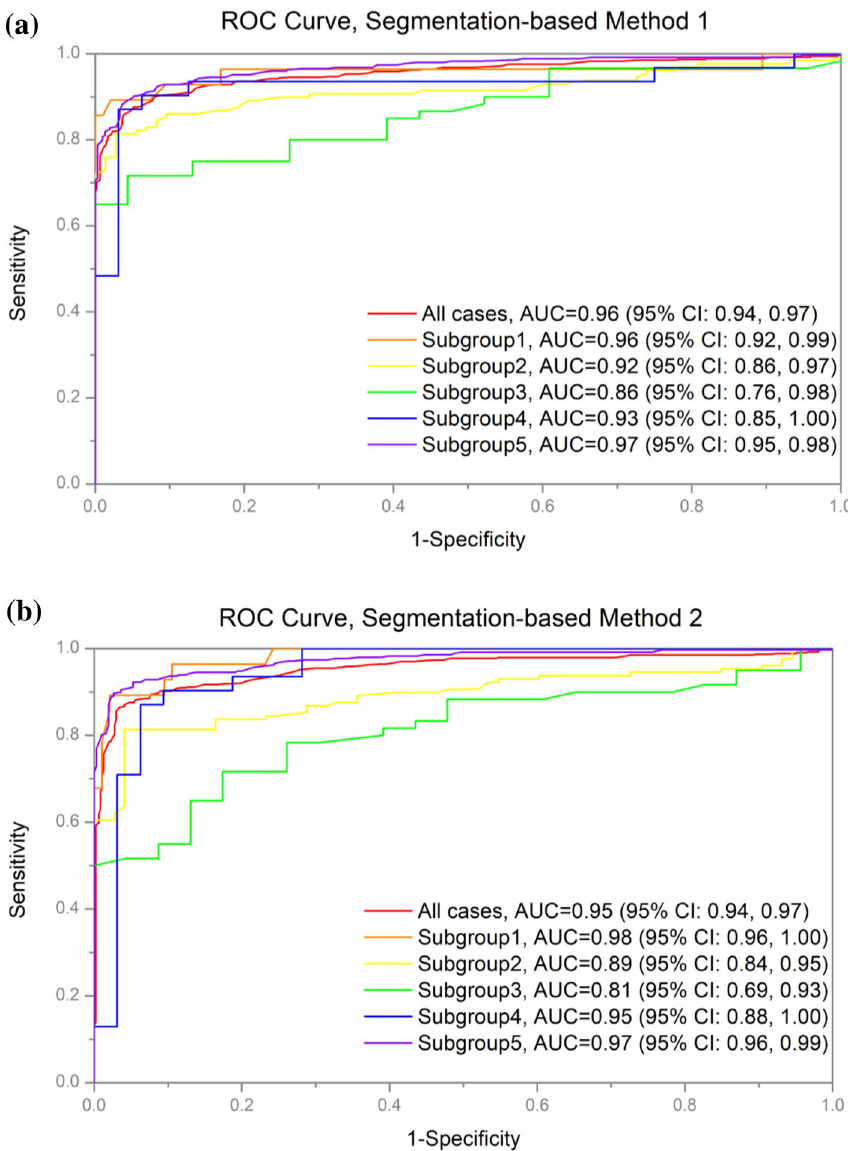
receiver operating characteristic